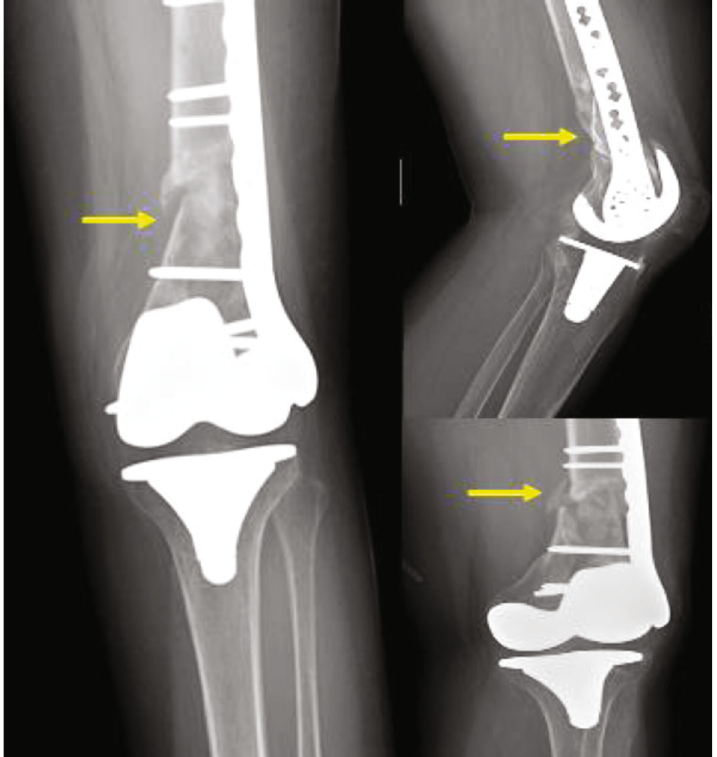
Figure 5: Postoperative follow-up AP and lateral radiographs done nine months after the surgery still showing nonunion, comminution, and low bone stock (yellow arrows).